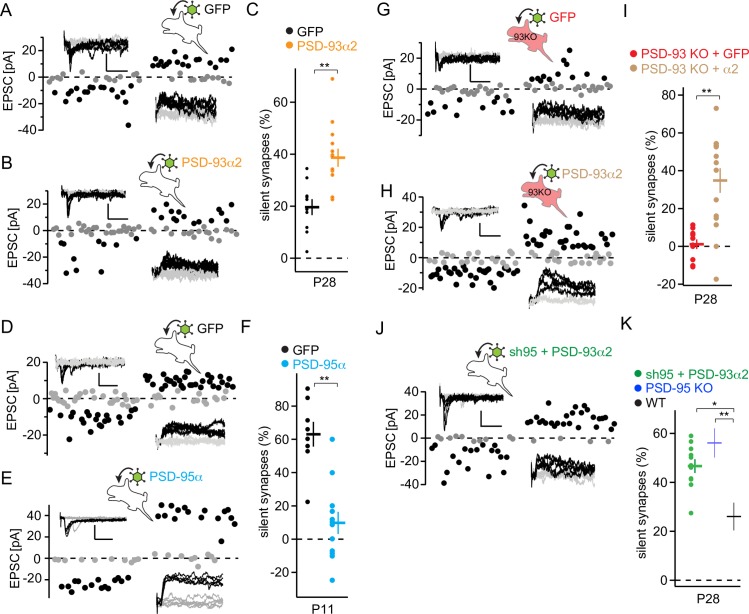
PSD-93α2 opposes PSD-95 function in the same molecular pathway.(A, B, D, E, G, H, J) Sample traces of V1 layer 2/3 pyramidal neuron EPSCs with minimal stimulation of P28 WT mice with AAV-GFP (A), with AAV-PSD-93α2 (B), with AAV-sh95 + PSD-93α2 (J), P11 WT mice with AAV-GFP (D), with AAV-PSD-95α (E), P28 PSD-93 KO mice with AAV-GFP (G) and with AAV-PSD-93α2 (H), with sample traces (inset) and analysis of the peak values of AMPA receptor EPSCs (downward deflection) or composite glutamate receptor EPSCs (upward deflection) of successes (black) and failures (gray) of individual EPSCs. Scale bar: 20 ms and 25 pA. Schematic drawing of stereotactic injection of indicated AAV into the visual cortex of P0 mice. (C, F, I, K) Summary graphs of the fraction of silent synapses of indicated manipulation (color code). Dots represent value of single neuron. Values for PSD-95 KO and WT mice (K) were obtained from Fig 1. *p < 0.05; **p < 0.01. Underlying data for this figure can be found in S1 Data. AAV, adeno-associated viral vector; AMPA, α-amino-3-hydroxy-5-methyl-4-isoxazole propionic acid; EPSC, excitatory postsynaptic current; GFP, green fluorescent protein; KO, knock-out; P, postnatal day; PSD, postsynaptic density; sh95, short hairpin RNA against PSD-95; V1, primary visual cortex; WT, wild-type.